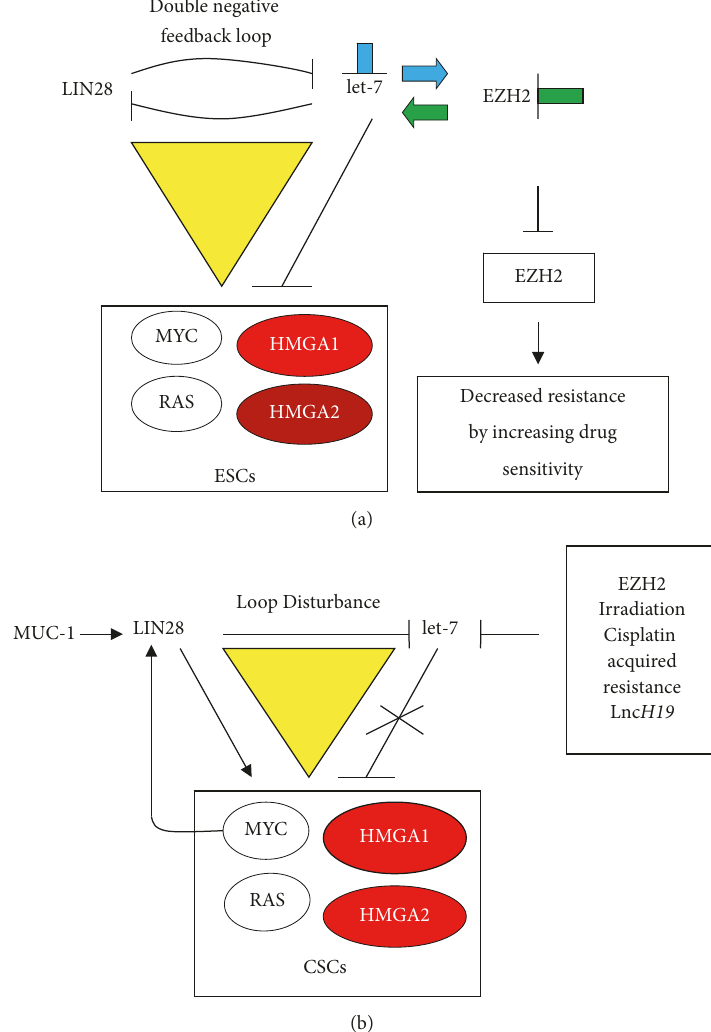
Figure 2: LIN28-miR-let-7 feedback loop and its regulation in ESCs and CSCs. Symbols are the same as shown in Figure